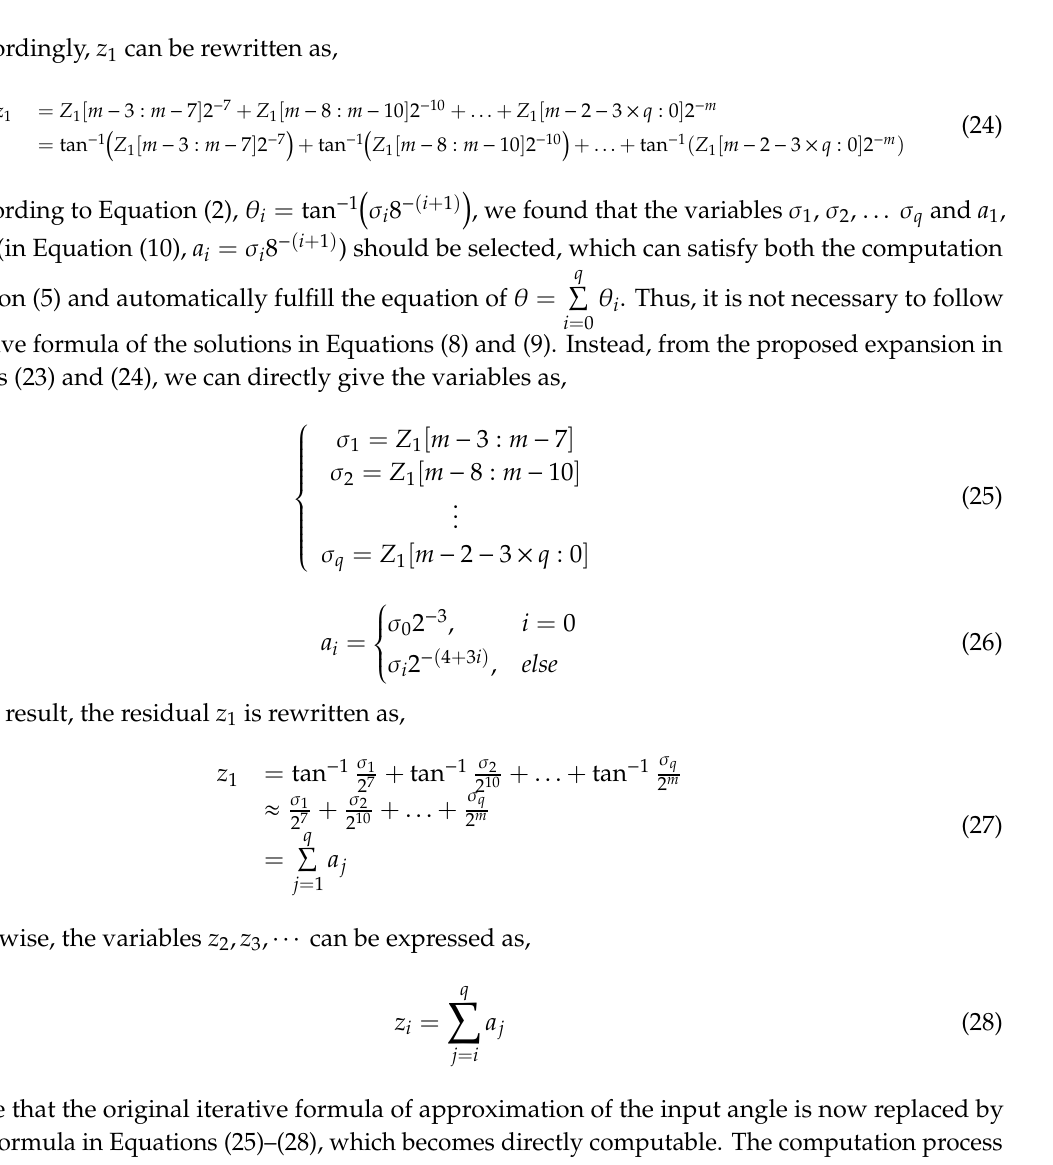
Figure 3. The architectures of the variable